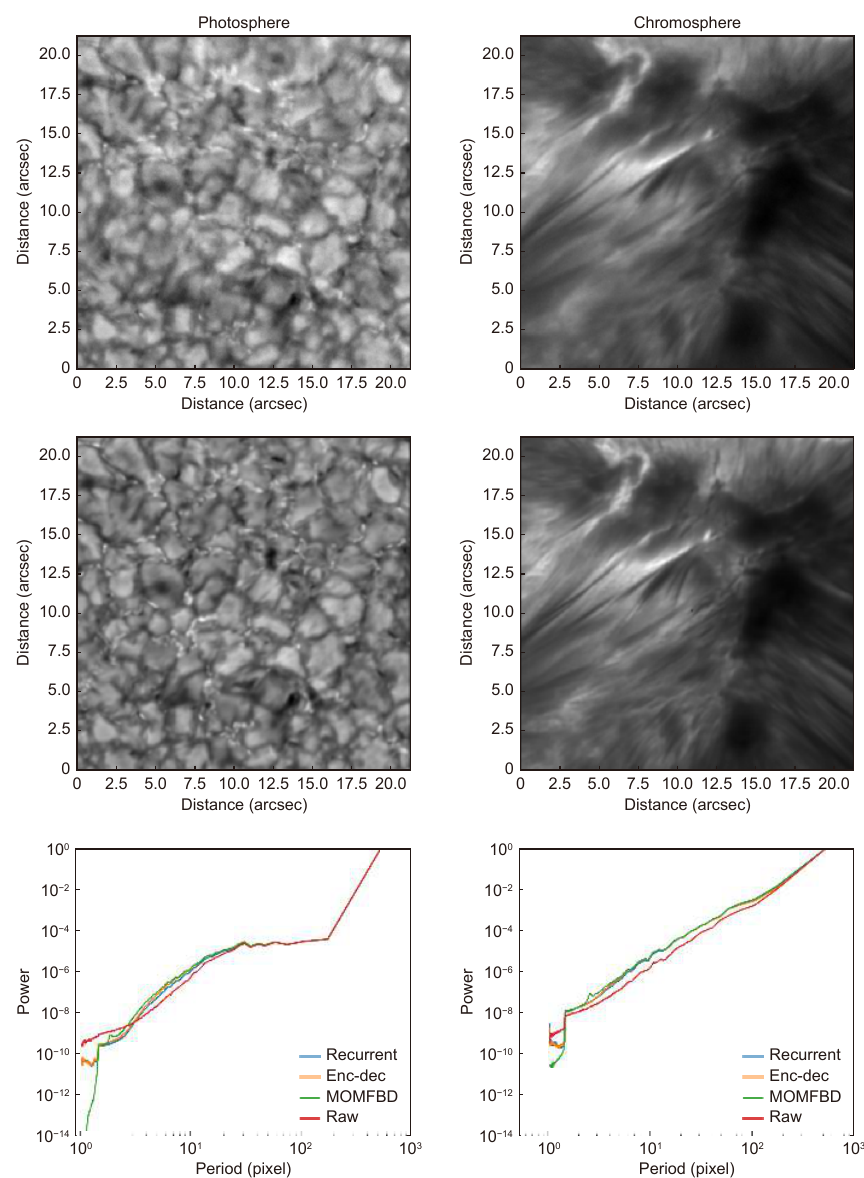
Fig. 17 | Top panels: a single raw image from the burst. Middle panels: reconstructed frames with the recurrent network. Lower panels: azi- muthally averaged Fourier power spectra of the images. The left column shows results from the continuum image at 6302 Å while the right column shows the results at the core of the 8542 Å line. All power spectra have been normalized to the value at the largest period. Figure repro- duced from ref. 95 ,